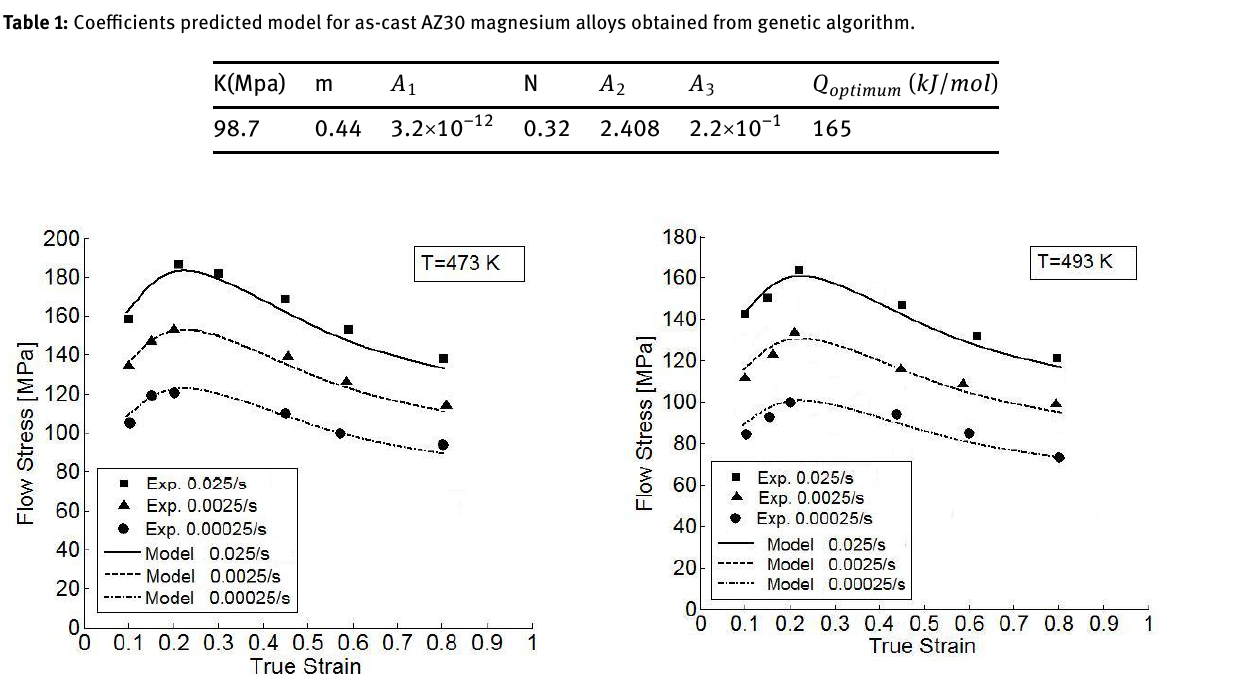
Figure 7: Predicted model and experimental data at temperature of 473 K and different forming rates.